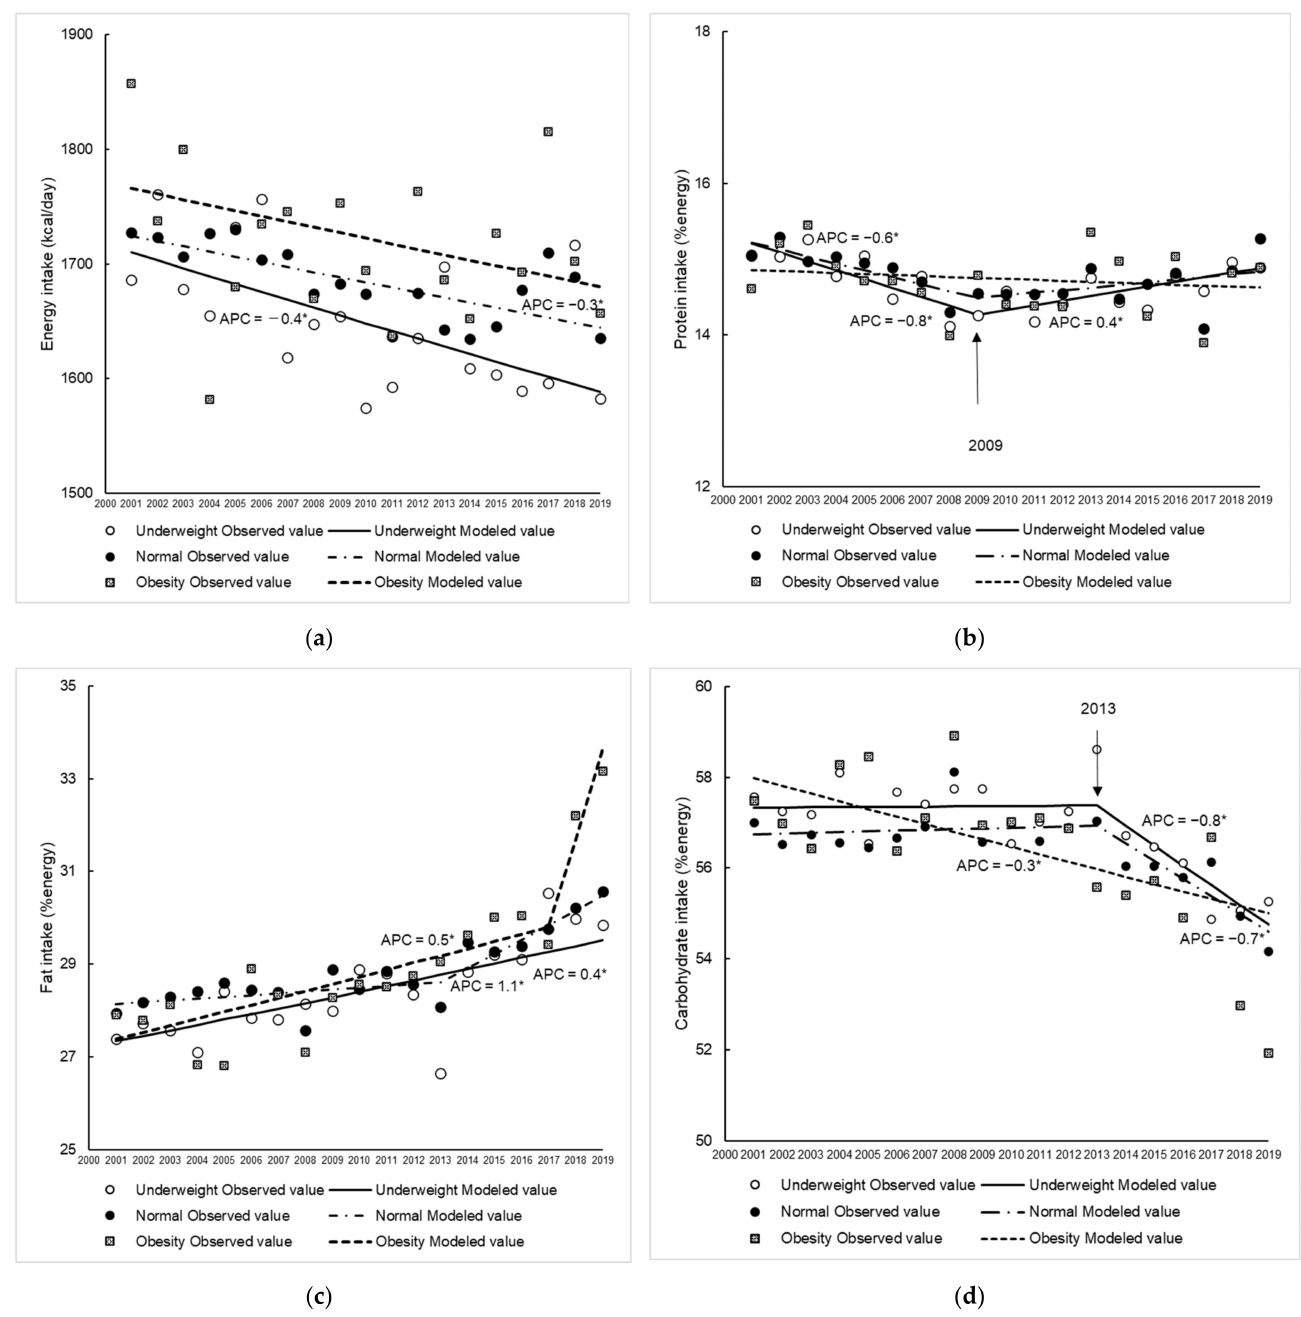
Figure 2. Trends in energy and macronutrient intake among young women classified as underweight, normal and obese between 2001 and 2019. Energy ( a ), protein ( b ), fats ( c ), carbohydrates ( d ). Trends in energy and macronutrient intake were analysed using Joinpoint regression analysis ( p < 0.05). APC, annual percentage change. * p <